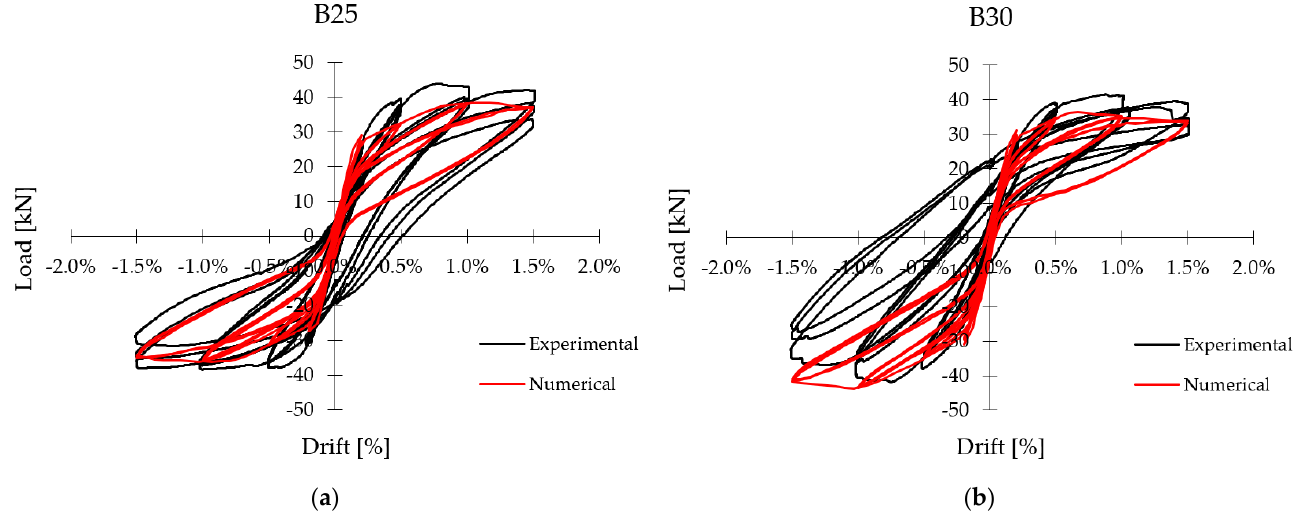
Figure 14. Comparison between experimental and numerical response, corroded specimens, MS 2. ( a ) Column B25, ( b ) Column B30.